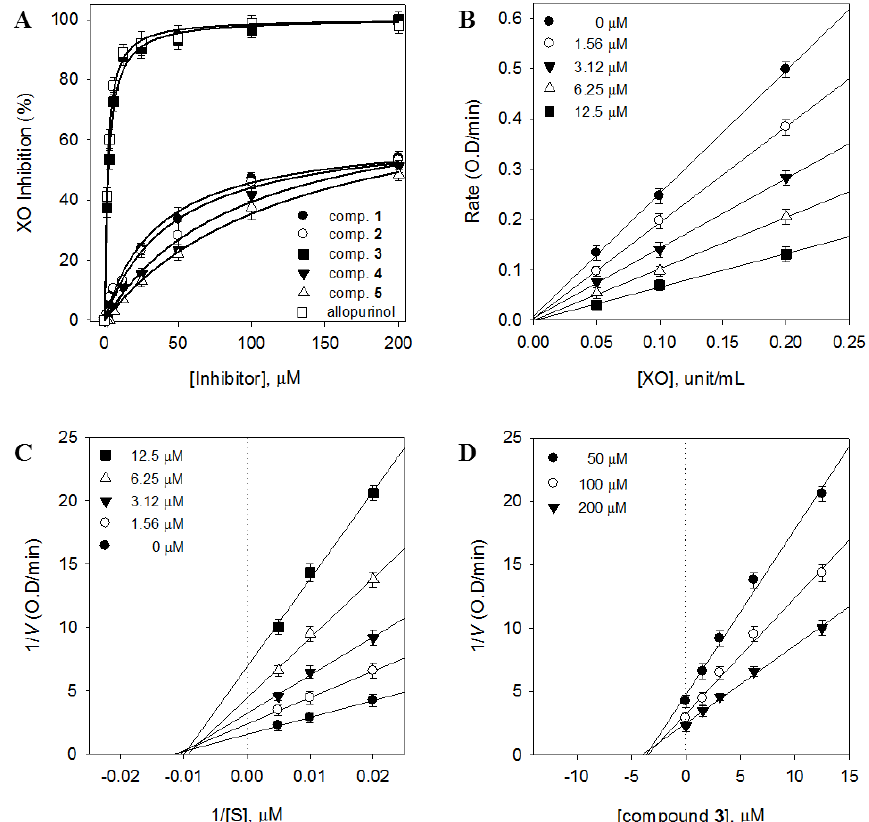
Figure 2. ( A ) Inhibitory effects of compounds ( 1 − 5 ) on the activity of xanthine oxidase (XO) for the oxidation of xanthine to uric acid. ( B ) Catalytic activity of XO as a function of enzyme concentration at different concentrations of compound 3 . ( C ) Lineweaver–Burk plots were constructed for the inhibition of XO by compound 3 . The plot is expressed as 1/velocity versus 1/xanthine (S) with or without an inhibitor in the reaction solutions. ( D ) Dixon plots of XO inhibition by compound 3 . The graphical symbols are substrate concentrations (50 μM, ●; 100 μM, ○ ; 200 μM, ▼ ).